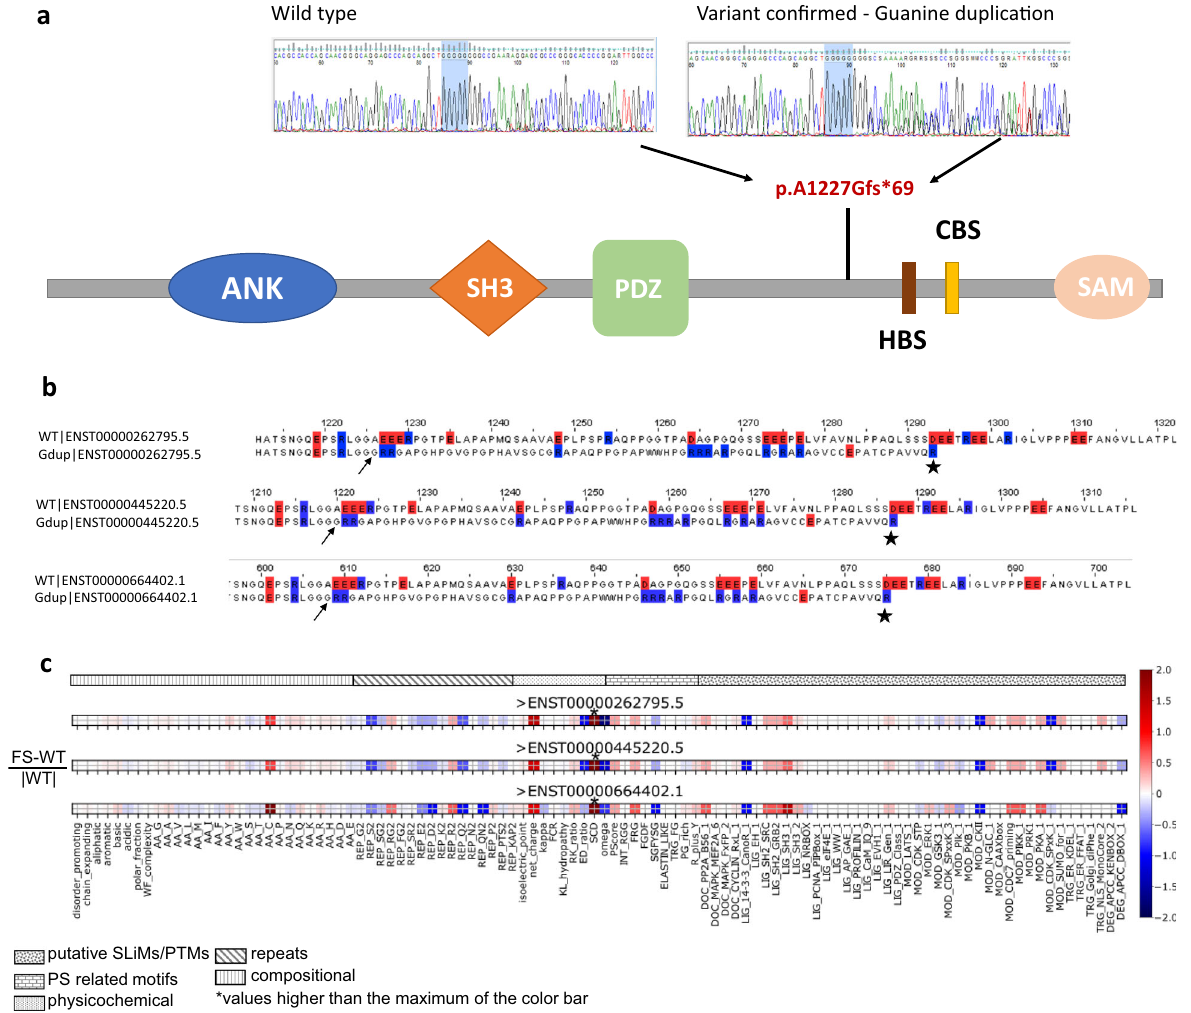
Fig. 3 Impact of the SHANK3 p.Ala1227Glyfs*69 variant on the protein. A (top left) Guanine string containing 8 Gs found in non-affected individuals; (top right) Guanine string containing nine Gs found in ASD-affected individuals and parents with somatic mutations; (bottom) Location of the frequent guanine duplication in the SHANK3 gene. ANK ankyrin repeats, SH3 SRC homology 3 domain, PDZ postsynaptic density 95/Discs large/zona occludens, HBS homer binding site, CBS cortactin binding site, SAM sterile alpha motif domain. B Alignment of wild type protein sequences, for each of three highly expressed splice isoforms, to the protein sequence of the variant around the position of the mutation; (note, in this fi gure the fi rst transcript presented is ENST00000262795.5 and the protein change for this is p.Ala1226Glyfs*69 as shown in Table 1). C Normalized impact of the variant for the three isoforms using FAIDR, a tool that identi fi es physical features and the presence of consensus protein recognition motifs in intrinsically disordered protein regions 56 . (*Note that SCD, sequence charge decoration, a measure of charge patterning associated with phase separation, has values signi fi cantly above 2: 5.4, 7.0, and 10.2 for the three